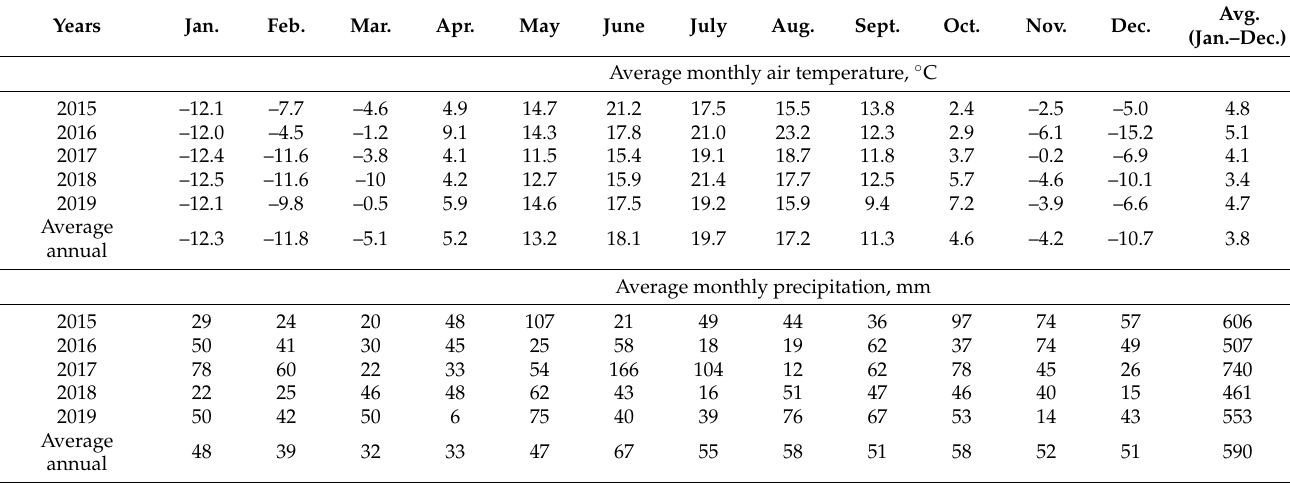
Table 2. The different treatments with PG, TL, and their combined application ratio.